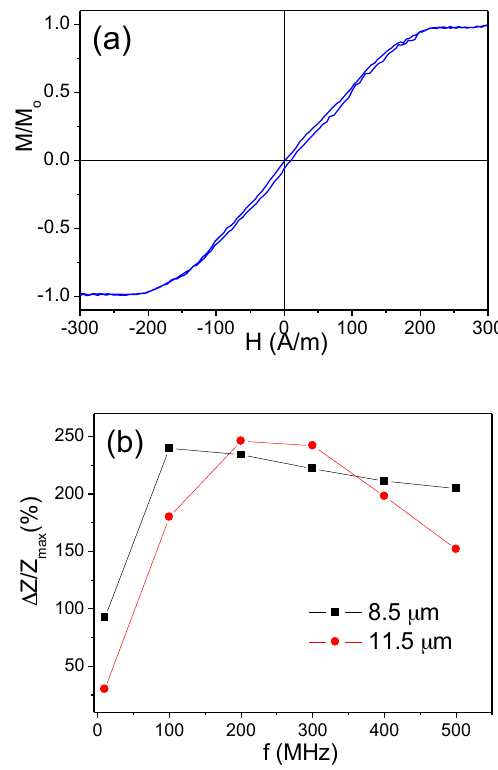
Fig. 1. Hysteresis loop(a) and frequency dependence of (b) measured in